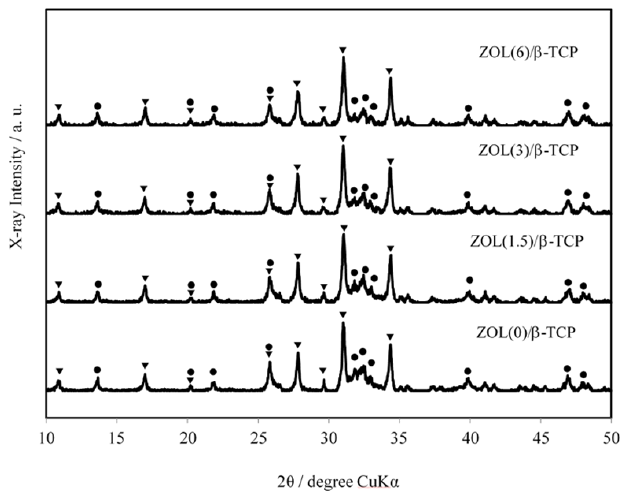
Figure 1. XRD patterns of zoledronic acid (ZOL)/β-tricalcium phosphate (β-TCP) powders. XRD patterns of the ZOL/β-TCP powders. ▼ ; β-TCP, ●; hydroxyapatite